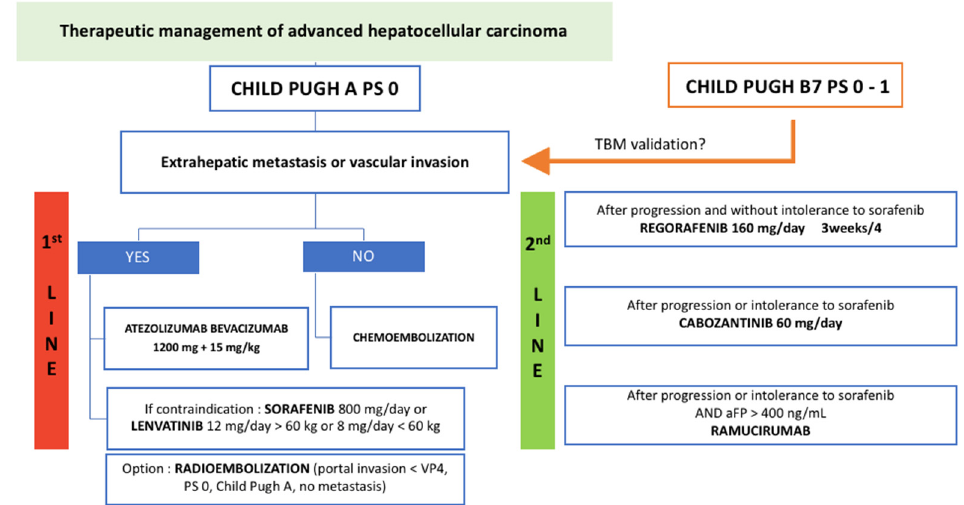
Figure 5. Algorithm proposition for therapeutic management of advanced hepatocellular carcinoma in patients with Child–Pugh A liver function. TBM: tumor board meeting.